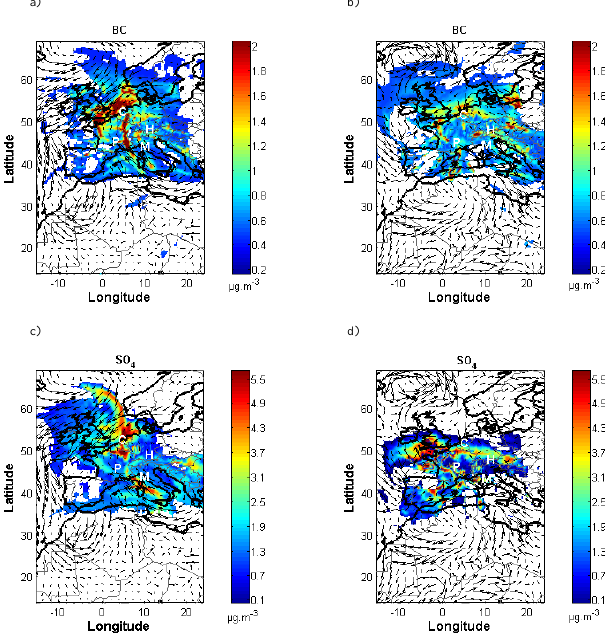
Figure 5. BC (a, b) and sulfate (c, d) mass concentration simulated by Meso-NH at 12:00UTC on 28 May (a, c) and 29 May (b, d) 2008. The locations of the Cabauw, Puy de Dôme, Hohenpeißen- berg and Mont Cimone sites are indicated by C, P, H and M respec-